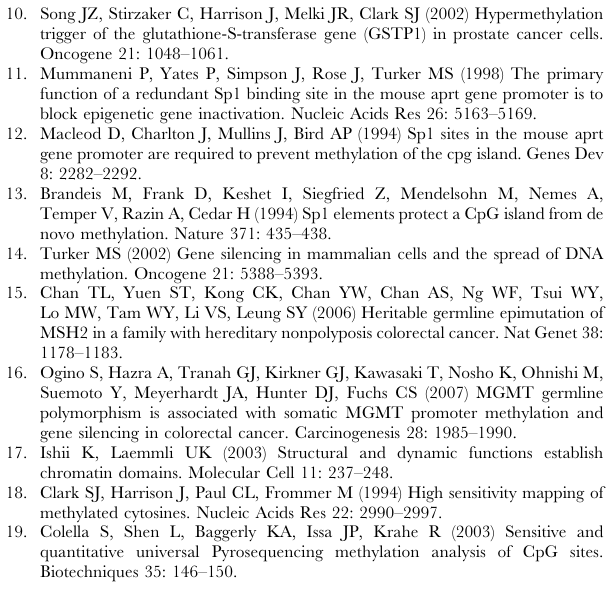
arrow points to the allele-specific band that is seen if the short allele is methylated. In the bottom of the gel, an allele non-specific band is seen, which is always present if RIL is methylated, regardless of allele status. After digestion of the COBRA products obtained from several homozygous and heterozygous tumors, we observed that among the 2 middle allele-specific bands, the predominant one is the lower band, which represents methylated short allele molecules. Note methylation of only the S allele in heterozygous cases C110 and C140. These findings led us to a suspicion that the short allele is more methylated than the long. Figure S2 Mixing study for pyrosequencing assay A. Normal blood (unmethylated) DNA was mixed with methylated DNA (RKO) at known ratios and subjected to bisulfite treatment. Then, pyrosequencing assay A (Figure 1A) was tested for bias of estimating methylation by studying mixed RKO, which has near 100% methylation as determined previously by COBRA, bisulfite sequencing, and pyrosequencing assays. The graph shows pyrosequencing measurement values determined for bisulfite- treated DNA of mixed RKO and normal blood in the ratio shown on the X-axis. Measured values are plotted alongside with expected methylation values, which are in fact very similar. Thus, we conclude that there is no bias in amplifying unmethylated vs. methylated DNA with the assay. Figure S3 The HpaII seeding of allele-specific construct B was done by HpaII methylase treatment and the plasmid methylation status prior to transfections was validated first by HpaII restriction enzyme (methylation sensitive) digestion. The gel image shows that while unmethylated allele-specific plasmids (lane 2, RIL-long and